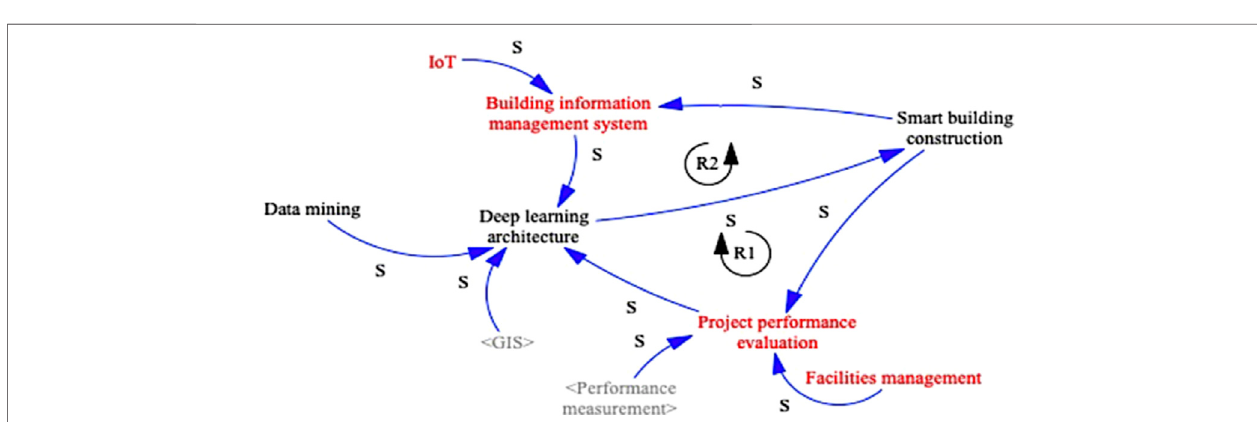
Frontiers in Built Environment |